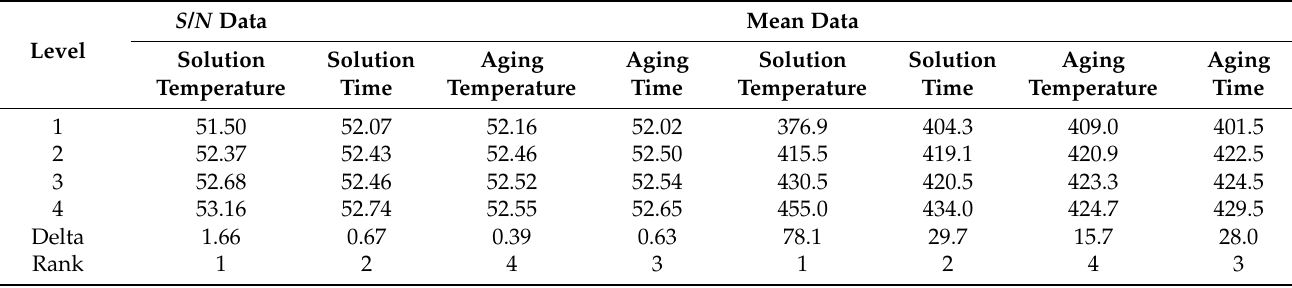
Table 5. Response table for signal-to-noise ratios (larger is better) and means for UTS.